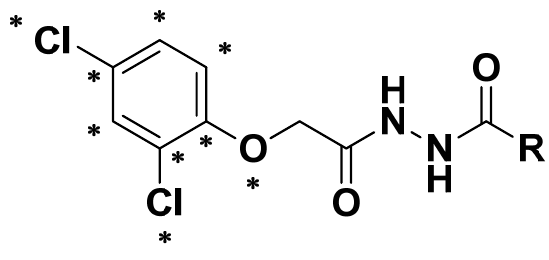
Figure 5. The asterisk skeleton of title compounds.